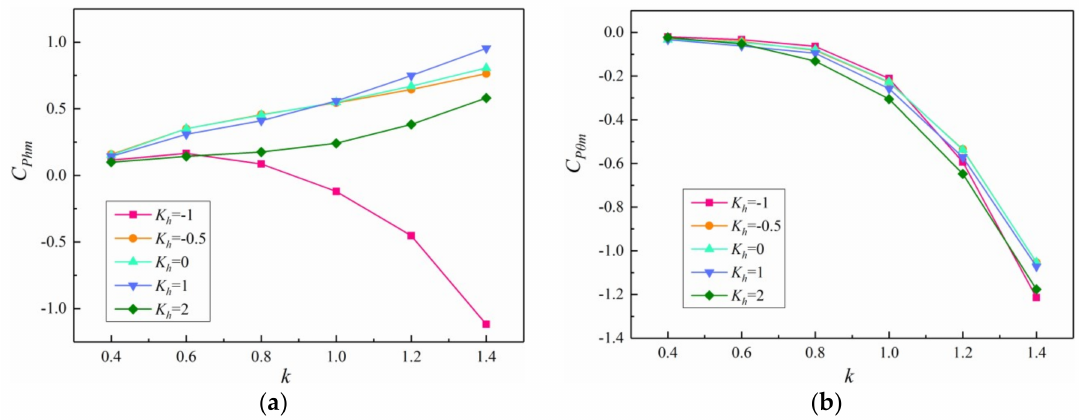
Figure 7. The C Phm and C P θ m of parallel foils at different K h : ( a ) C Phm curves under different k ; ( b ) C P θ m curves under different k .